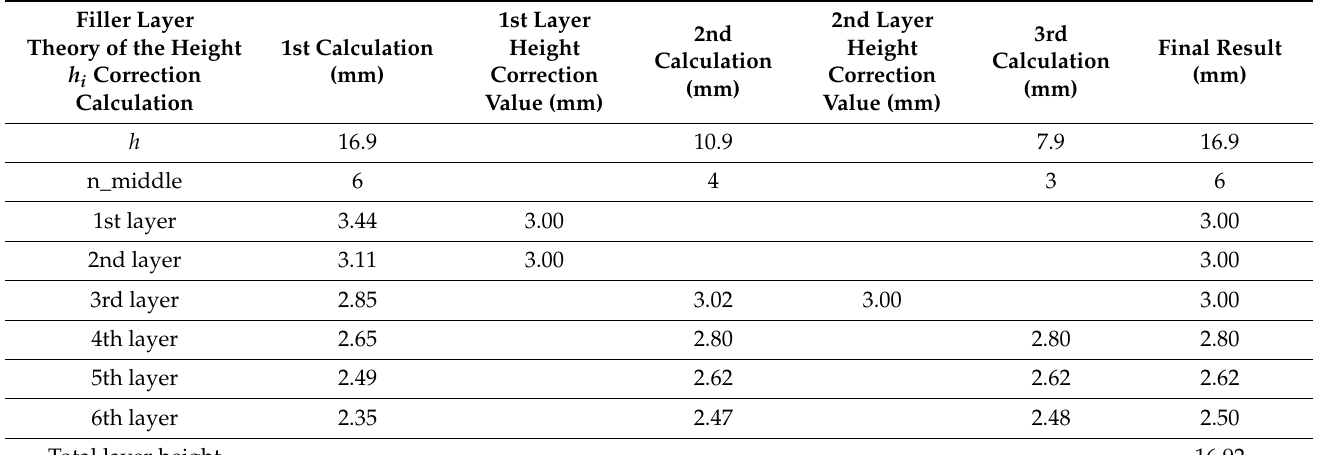
Table 3. The calculation process of an uplift prediction model with upper and lower limit